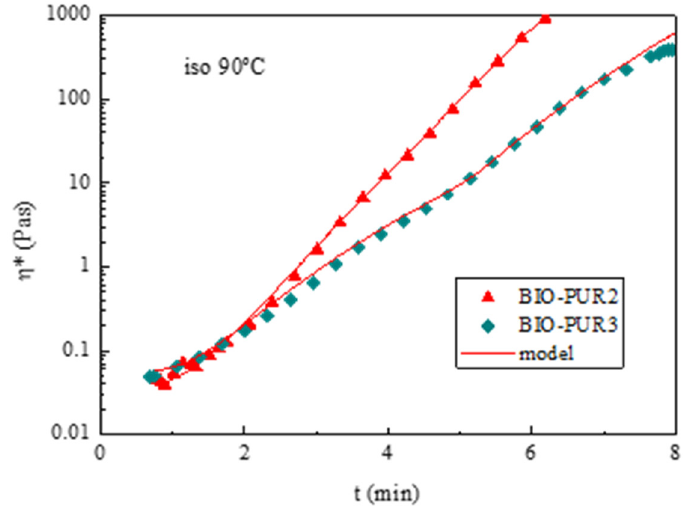
Figure 7. Viscosity evolution with time at 90 °C for BIO-PUR2 and BIO-PUR3. Experimental results (symbols) and model (red lines).